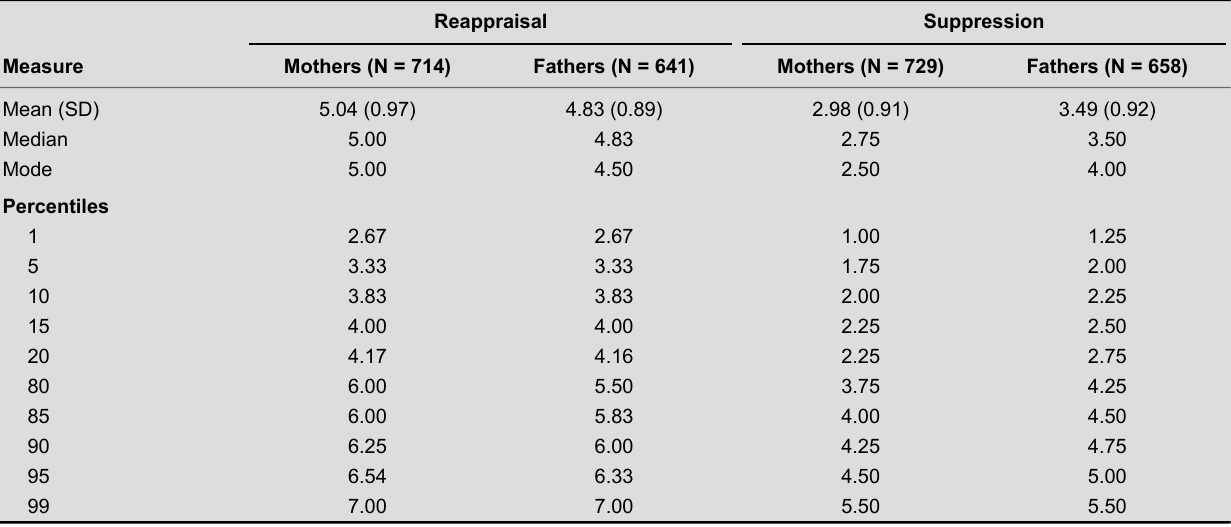
Norms (Mean, Median, Mode and Percentiles) for the ERQ Reappraisal and Suppression Scale for Mothers and Fathers, Respectively